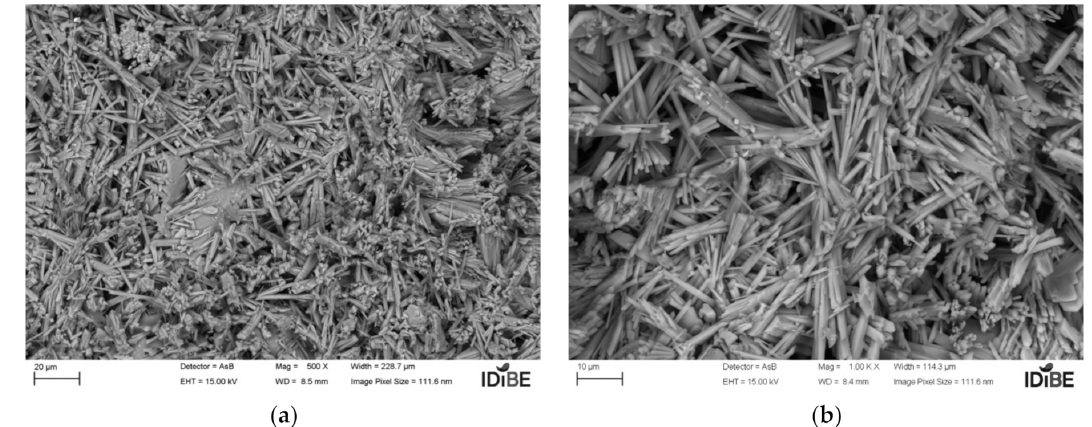
Figure 4. Micrograph of the 0.6% modified melamine compound (lot A2): ( a ) 20 µ m; ( b ) 10 µ m (source: the author).